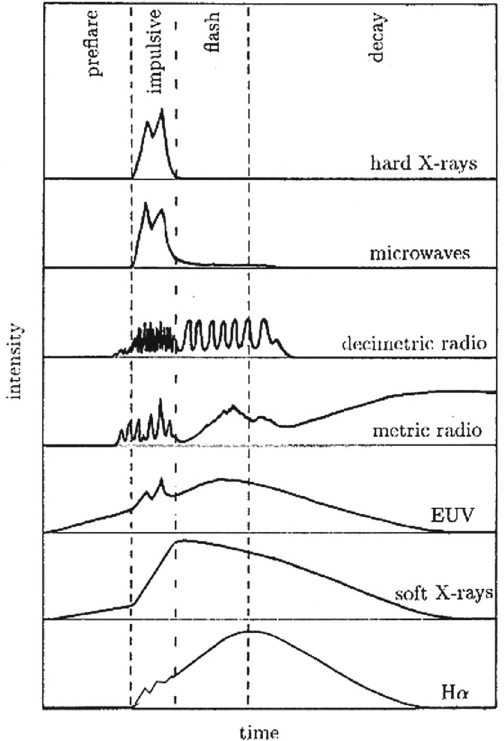
Fig. 2 A schematic profile of the flare intensity at several wavelengths. The various phases indicated at the top vary greatly in duration. In a large event, the preflare phase typically lasts a few minutes, the impulsive phase 3–10 min, the flash phase 5–20 min, and the decay one to several hours. Image reproduced with permission from Benz (2002), copyright by